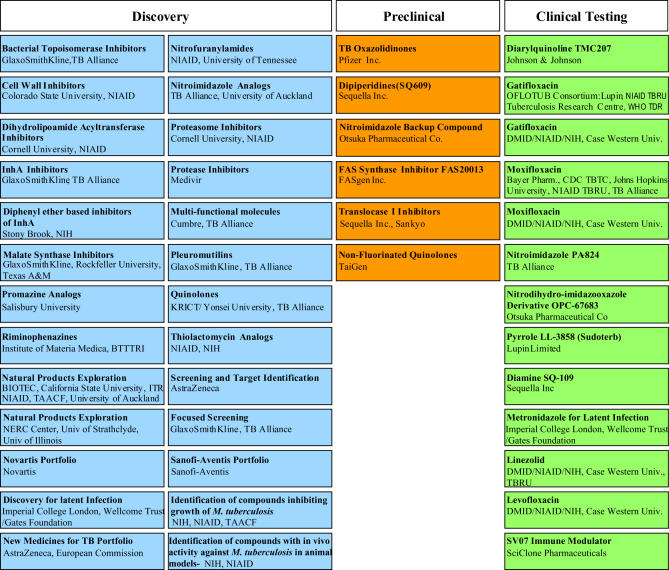
Global TB Drug Pipeline, January 2007 (Figure: Kindly provided by STOP TB Partnership Working Group on New TB Drugs)BTTTRI, Beijing Tuberculosis and Thoracic Tumor Research Institute; CDC, Centers for Disease Control and Prevention; DMID, Division of Microbiology and Infectious Diseases; ITR, Institute for Tuberculosis Research; KRICT, Korean Research Institute of Chemical Technology; NERC, Natural Environment Research Council; NIAID, National Institute of Allergy and Infectious Disease; NIH, National Institutes of Health; TAACF, Tuberculosis Antimicrobial Acquisition and Coordinating Facility; TBRU, Tuberculosis Research Unit; TBTC, Tuberculosis Trials Consortium; TDR, Special Programme for Research and Training in Tropical Diseases; WHO, World Health Organization